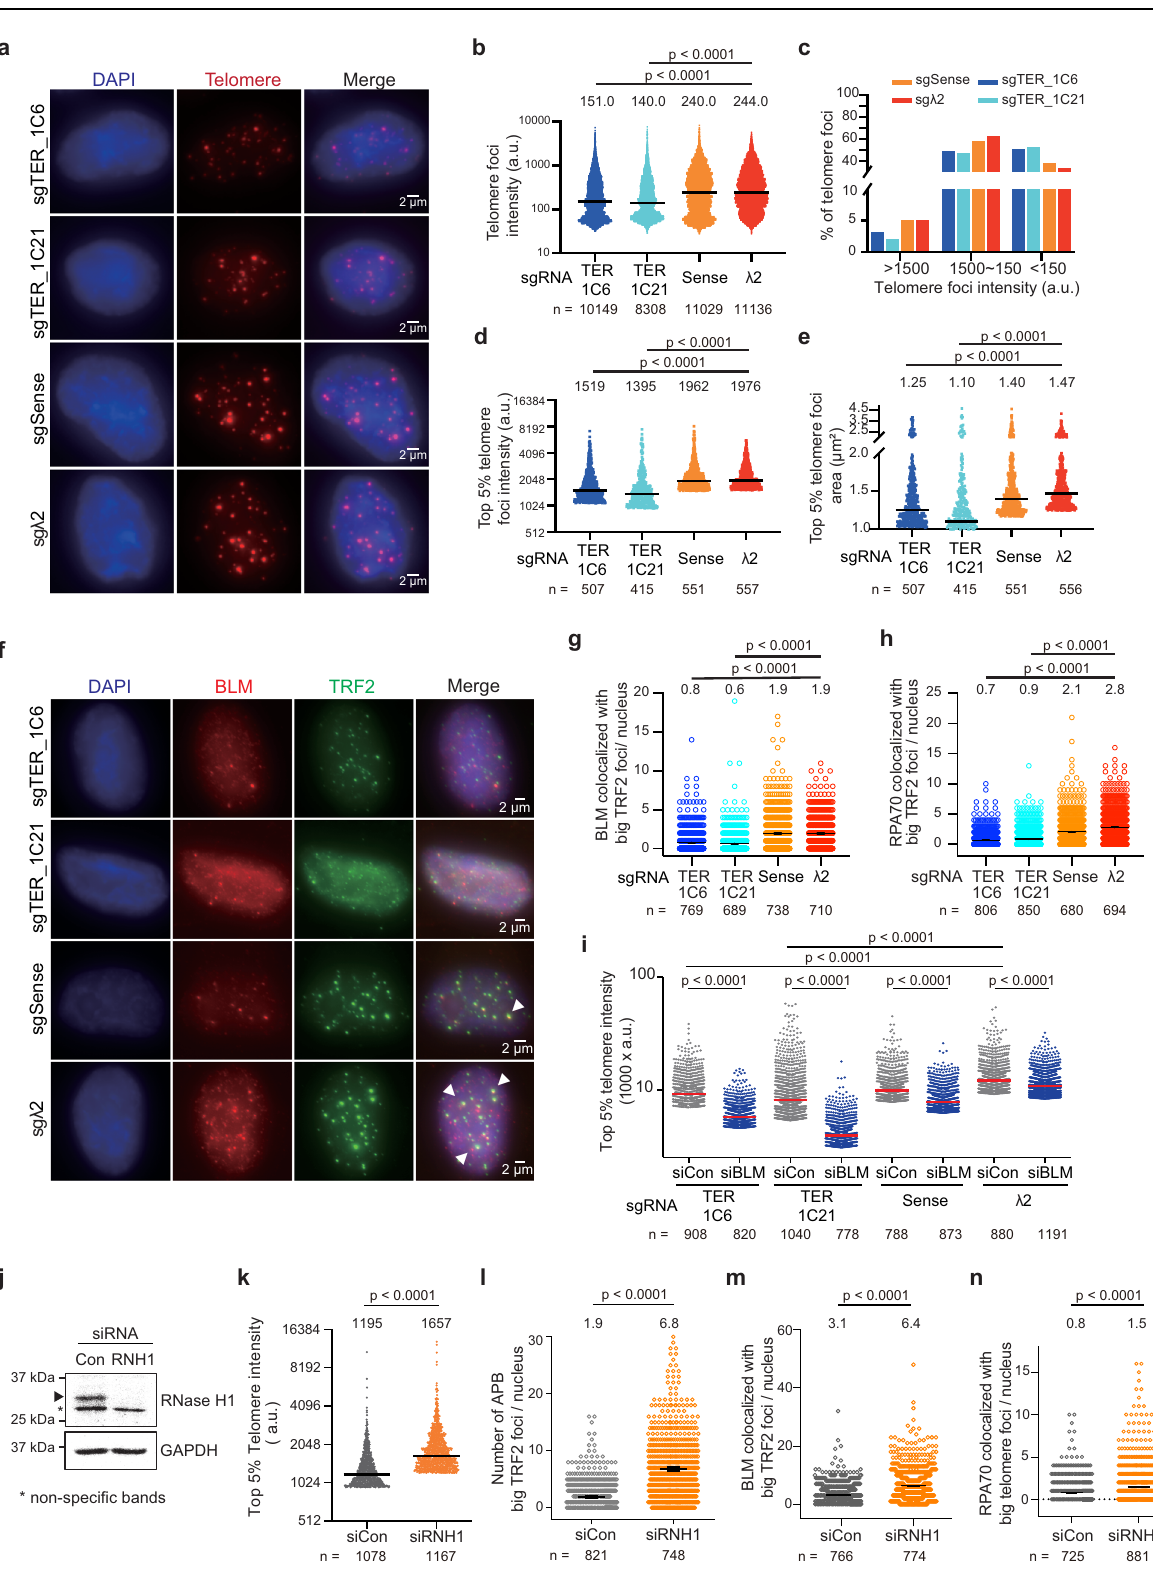
excision repair factor (TC-NER) Cockayne syndrome group B (CSB), XPG, and XPF are all required for processing genomic R-loops